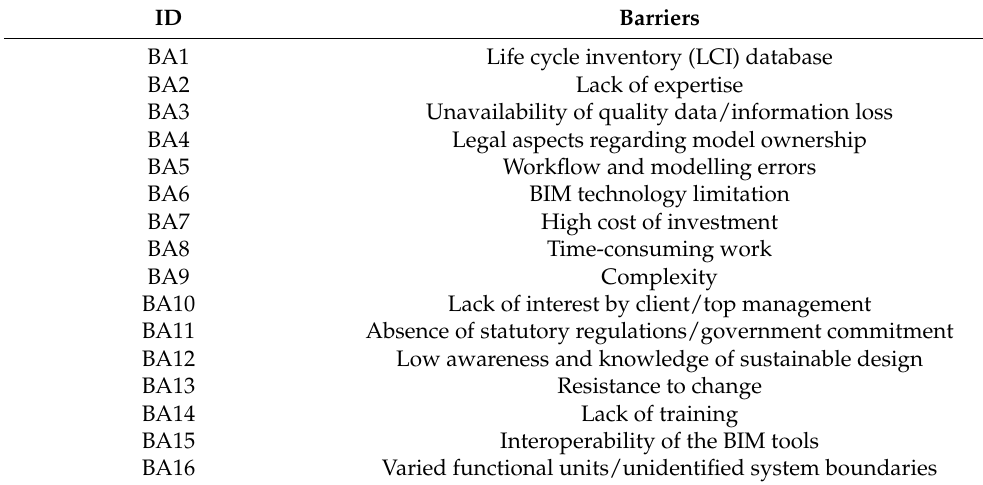
Table 3. Aggregated barriers to life cycle sustainability assessment integration with